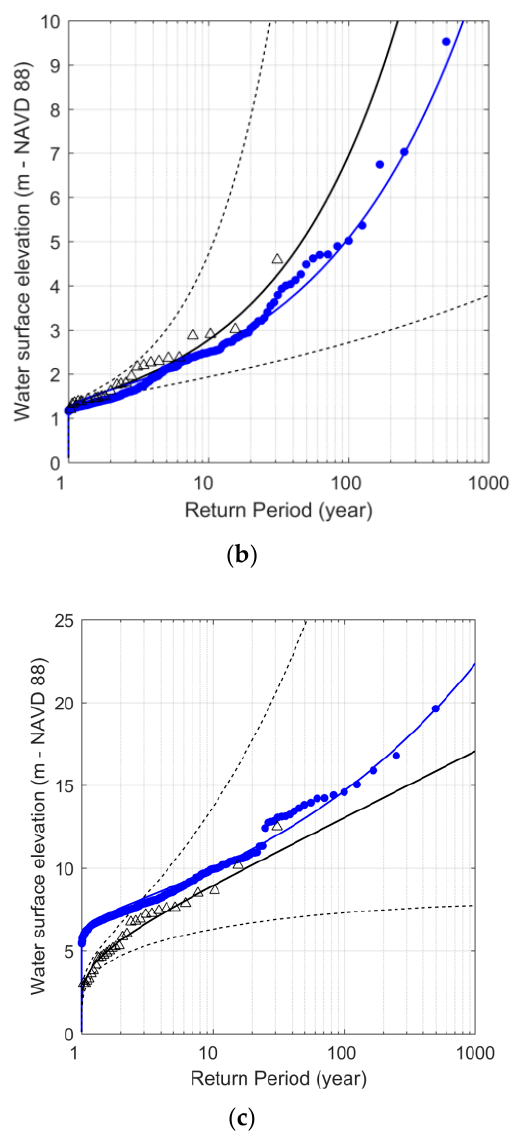
Figure 5. Comparison of the annual exceedance probability distributions from observed and modeled annual maxima at stations HM ( a ), HTB ( b ) and HBB ( c ). The dashed lines indicate the fit of the 95% confidence interval from the empirical GEV distribution parameters. The stations are presented from downstream to upstream along the Buffalo Bayou river, with stations HM and HTB located in the Port of Houston, see also Figures 1 and 4 for their exact location.